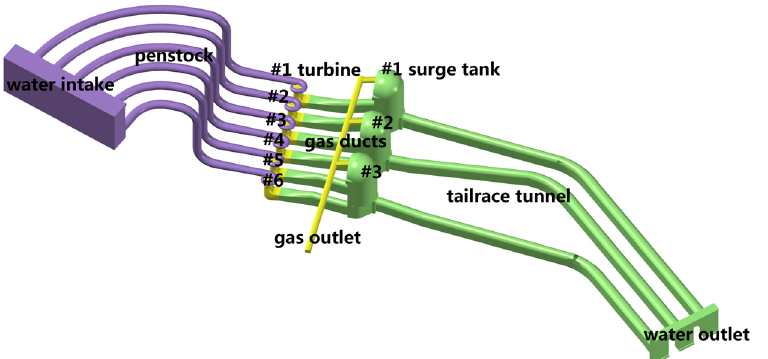
Figure 34. Computational